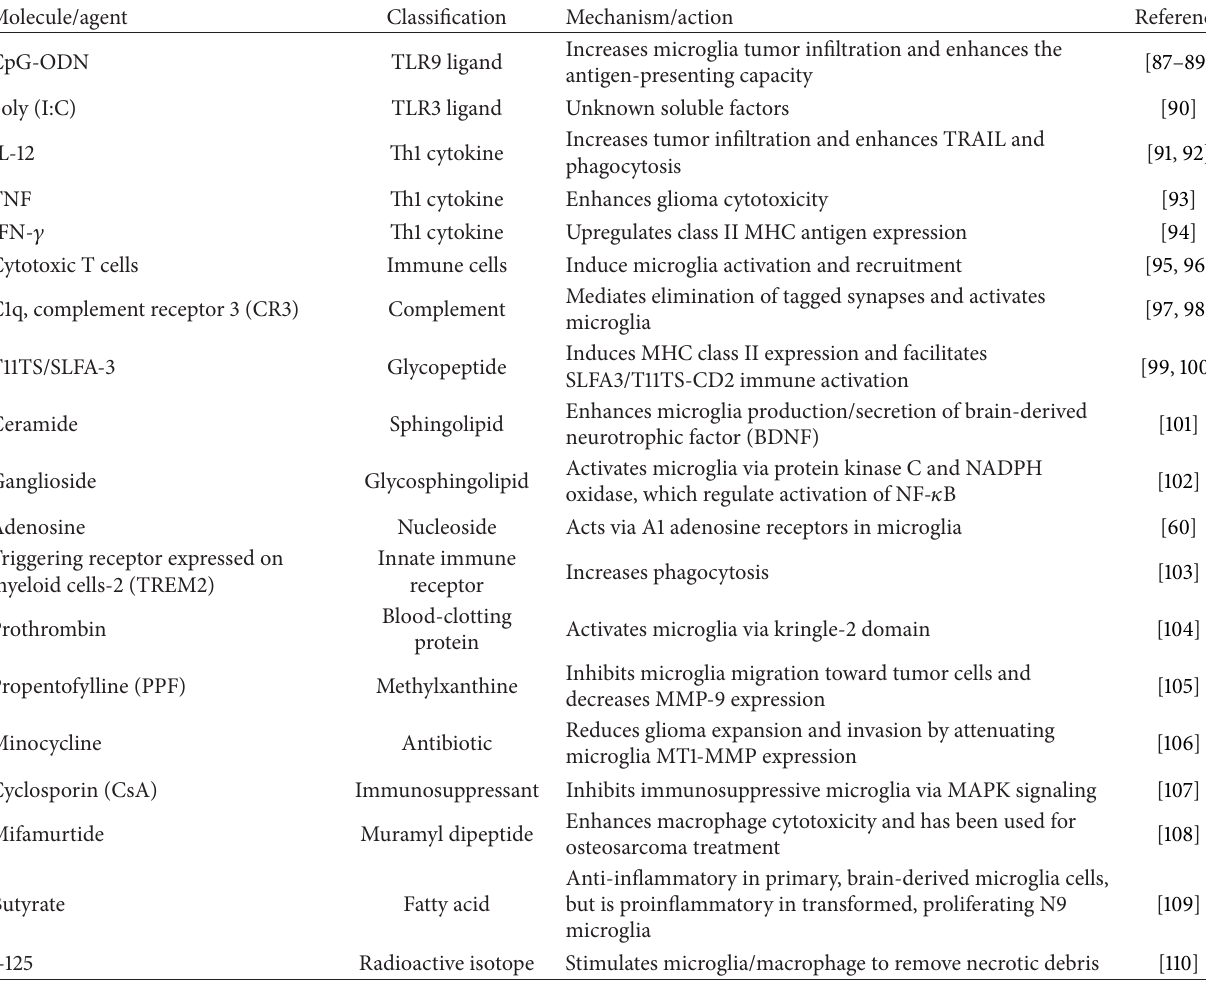
Table 1: Microglia activating